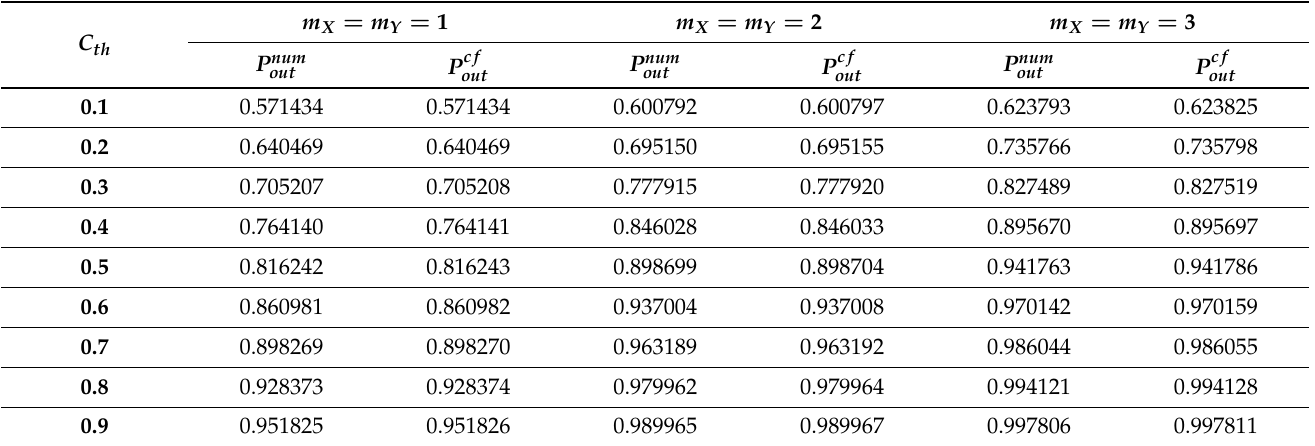
Table 2. A comparison between numerical and closed-form solutions for N = 20, ¯ γ M = ¯ γ W = 10 dB, Ω = Ω = 0 dB, with various C X Y th and shadowing coefficients.